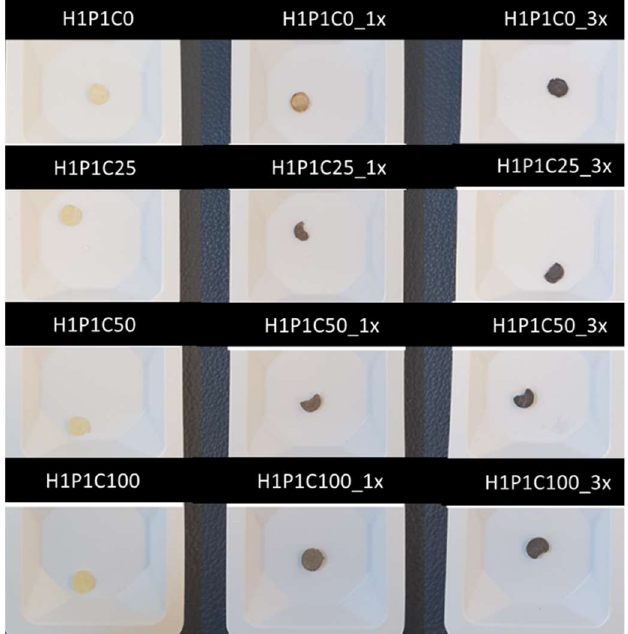
Figure 5. Representative digital images of samples after Von Kossa staining applied to unmineralized hydrogels (H1P1C) and to hydrogels treated with one Ca/P cycle (H1P1C_1x), and three cycles (H1P1C_3x).